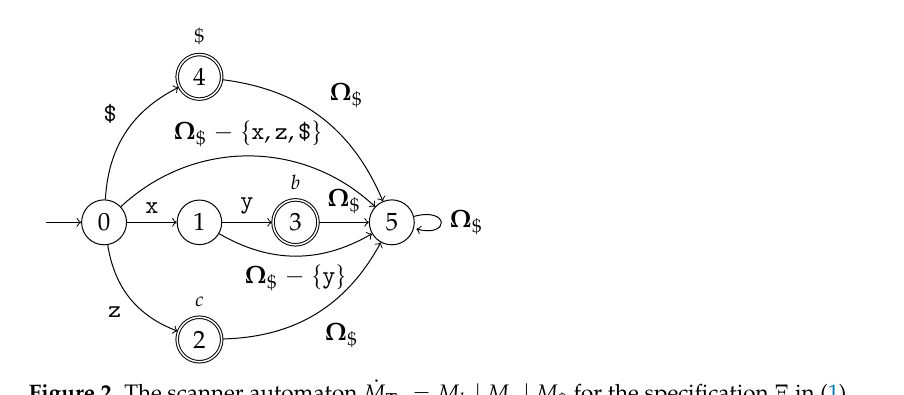
Figure 1. The handle-finding automaton for the specification Ξ in (1), constructed using G 1 .